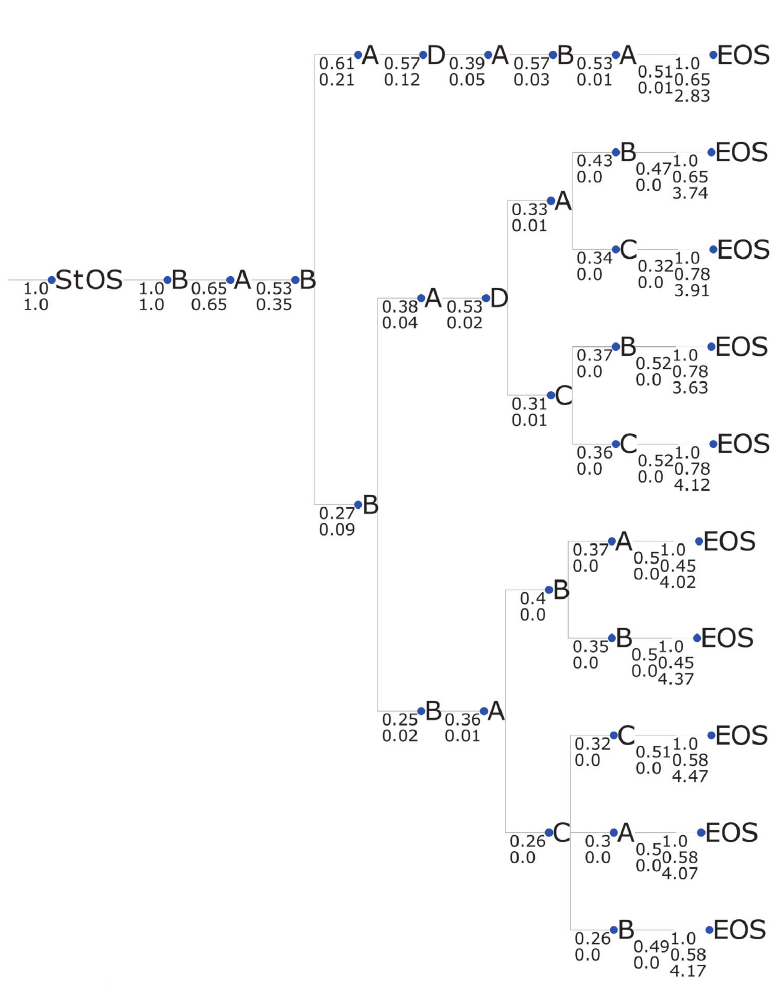
Figure 16: Output of the seq2probTree method for the tree-based system with input sequence